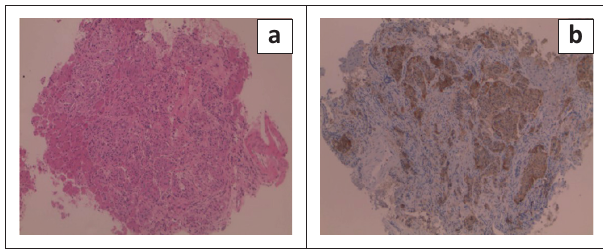
FIGURE 2: Histological slides from liver lesions: (a) HE staining showing polyglandular tumour cells with granular eosinophilic cytoplasm and glandular formation and (b) strongly positive immuno-histochemical synaptophysin stain (specific for neuroendocrine